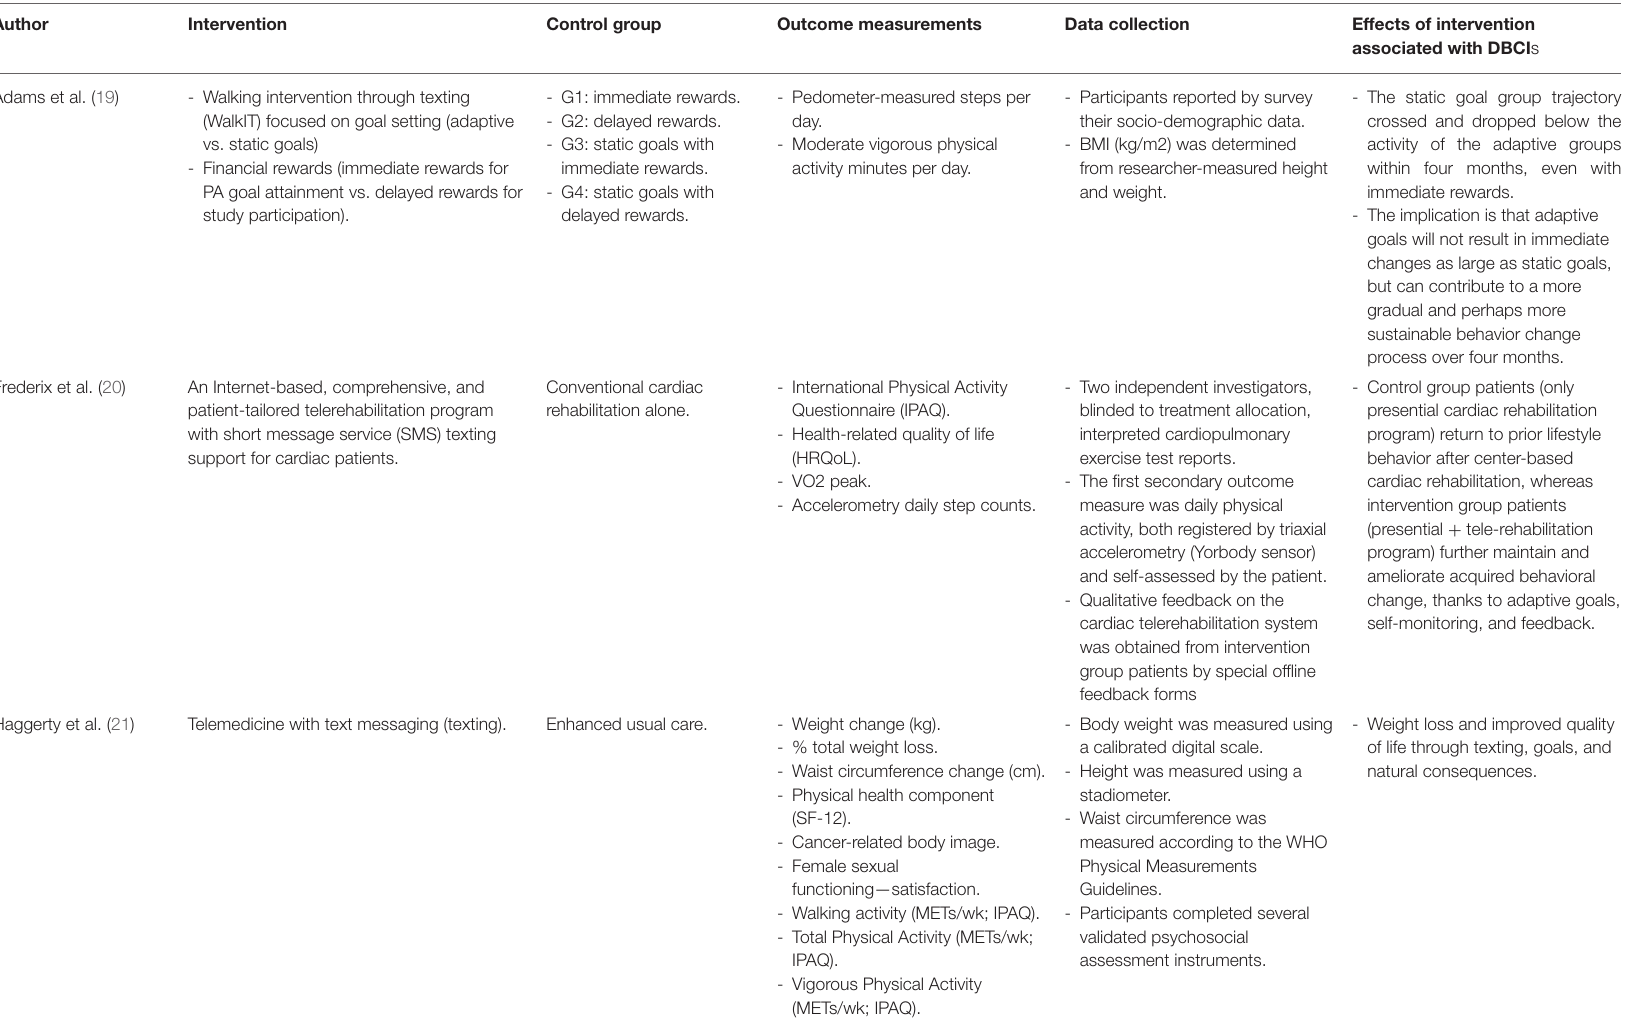
TABLE 4 | Outcomes of interest of the selected